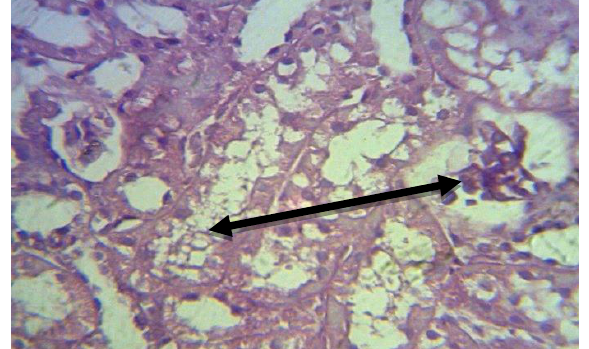
Fig. 2: Kidney of animal in T1 group 42 day post treated shows severe vacuolar degeneration of epithelial lining cells of renal tubules with atrophy of glomerular tufts (H and E stain 40x).